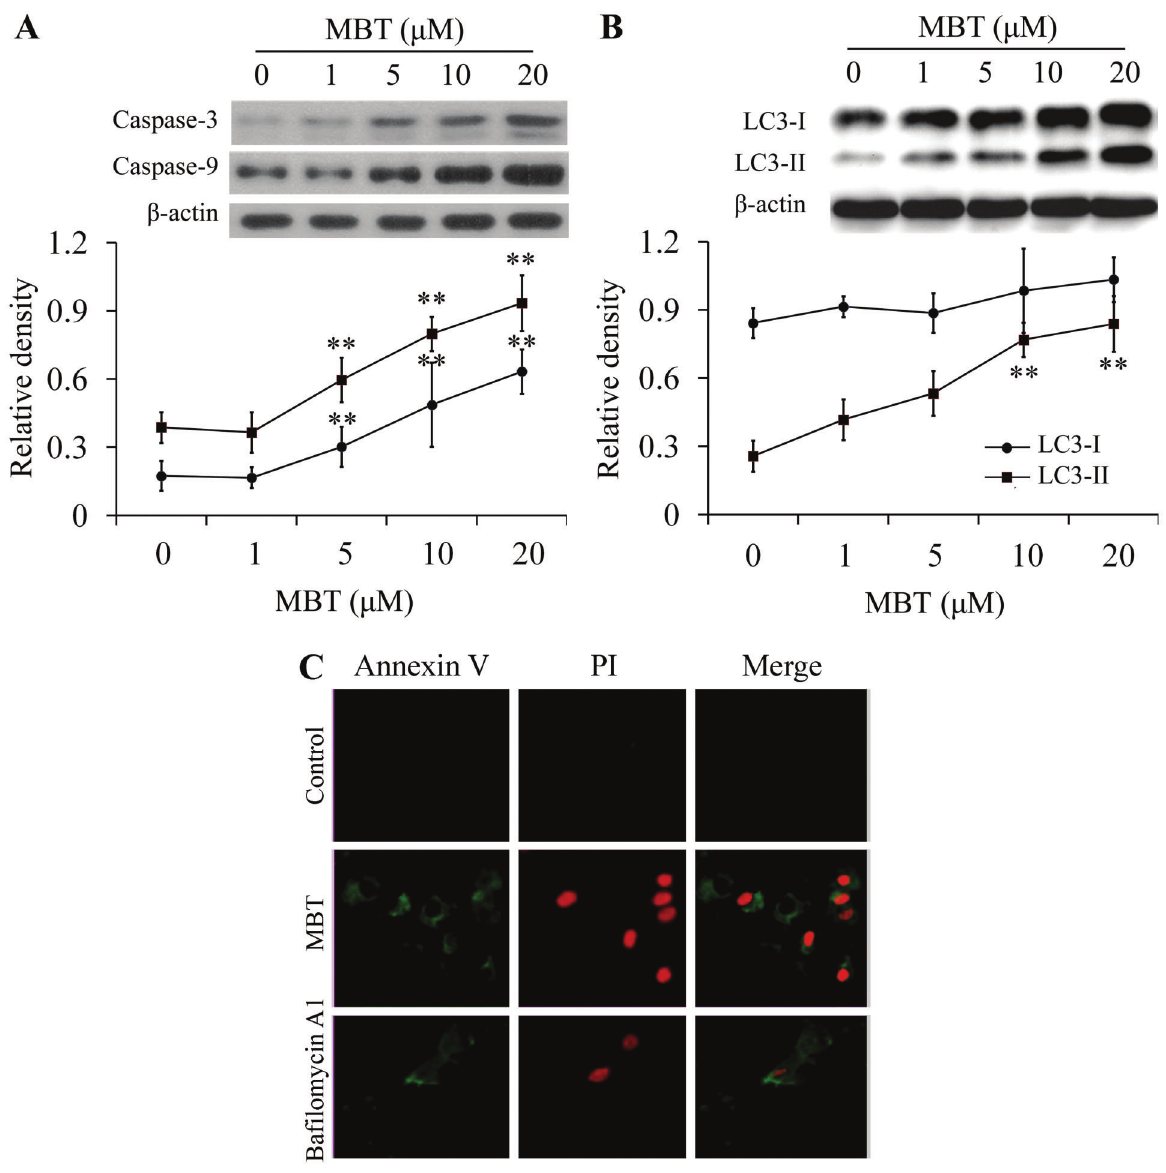
Figure 3. Apoptosis ( A ) and autophagy markers ( B ) in 2-methyl-2-butanol (MBT)-treated HXO-RB44 cells assayed by western blot (n=4). Data are reported as means ± SD. C , Apoptosis and necrosis detected by Annexin V-FITC and PI double fl uorescence staining. **P o 0.01 vs 0